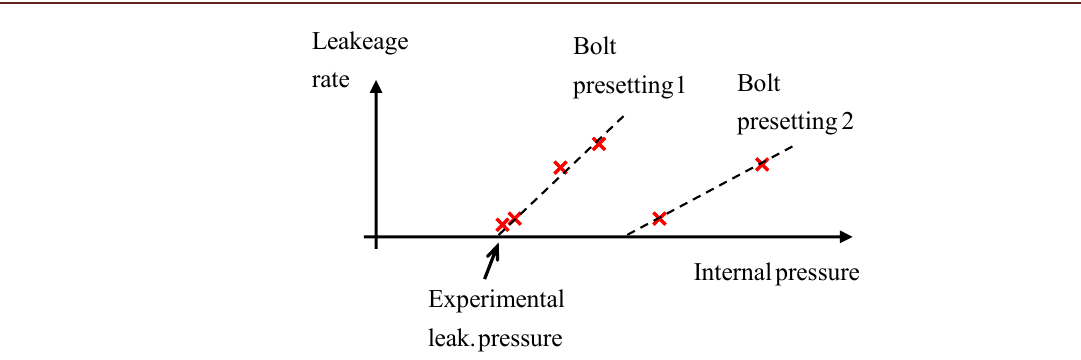
Figura 11: Definizione sperimentale della pressione di perdita.